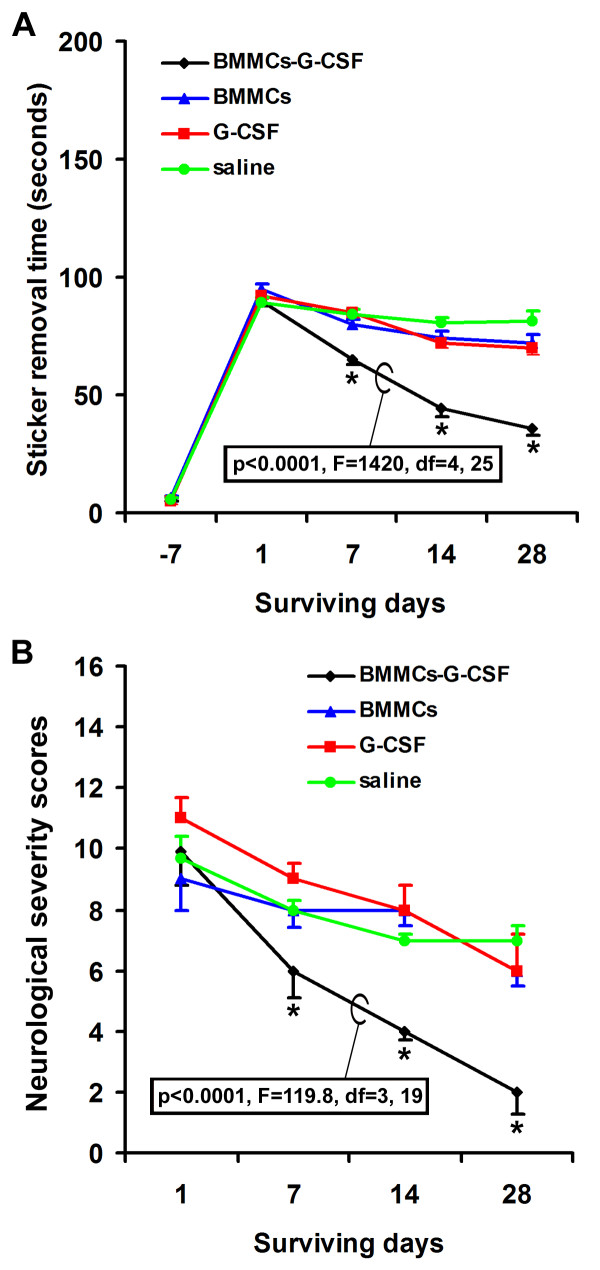
Neurological evaluation of mice prior to and after middle cerebral artery occlusion. The upper graph (A) shows the average time scores for adhesive-removal in the 4 animal groups at various surviving points. Mice with BMMCs transplantation combined with G-CSF administration spend less time to remove the adhesive paper on their forearm relative to other groups. The low graph (B) plots the modified neurological severity scores (mNSS) in the 4 animal groups at different time points. The extent of neurological function impairment is significantly less in the BMMCs-G-CSF group relative to other groups, and also reduces with increasing surviving time overall. No differences exist before and at day one after ischemic lesion for either adhesive removal or mNSS scores.